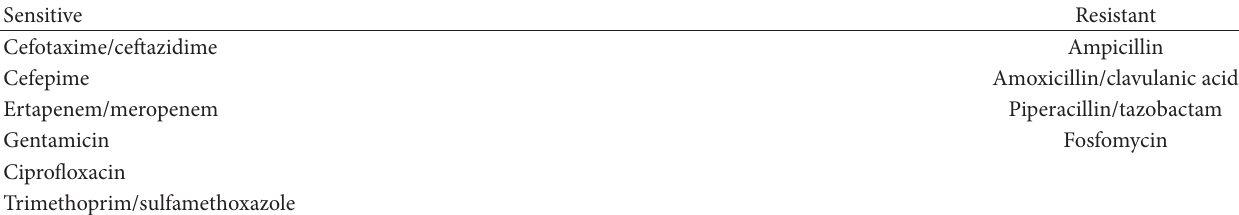
Table 1: Susceptibility testing of H. alvei recovered from the blood culture.